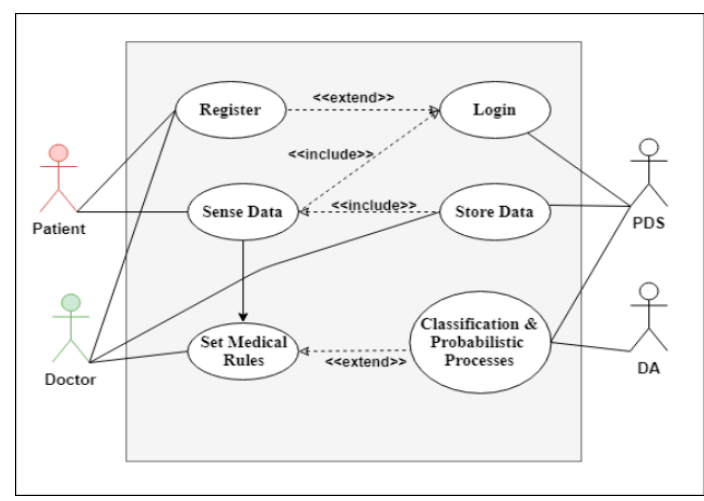
Figure 6. Use case diagram for the digital health system (DHS).